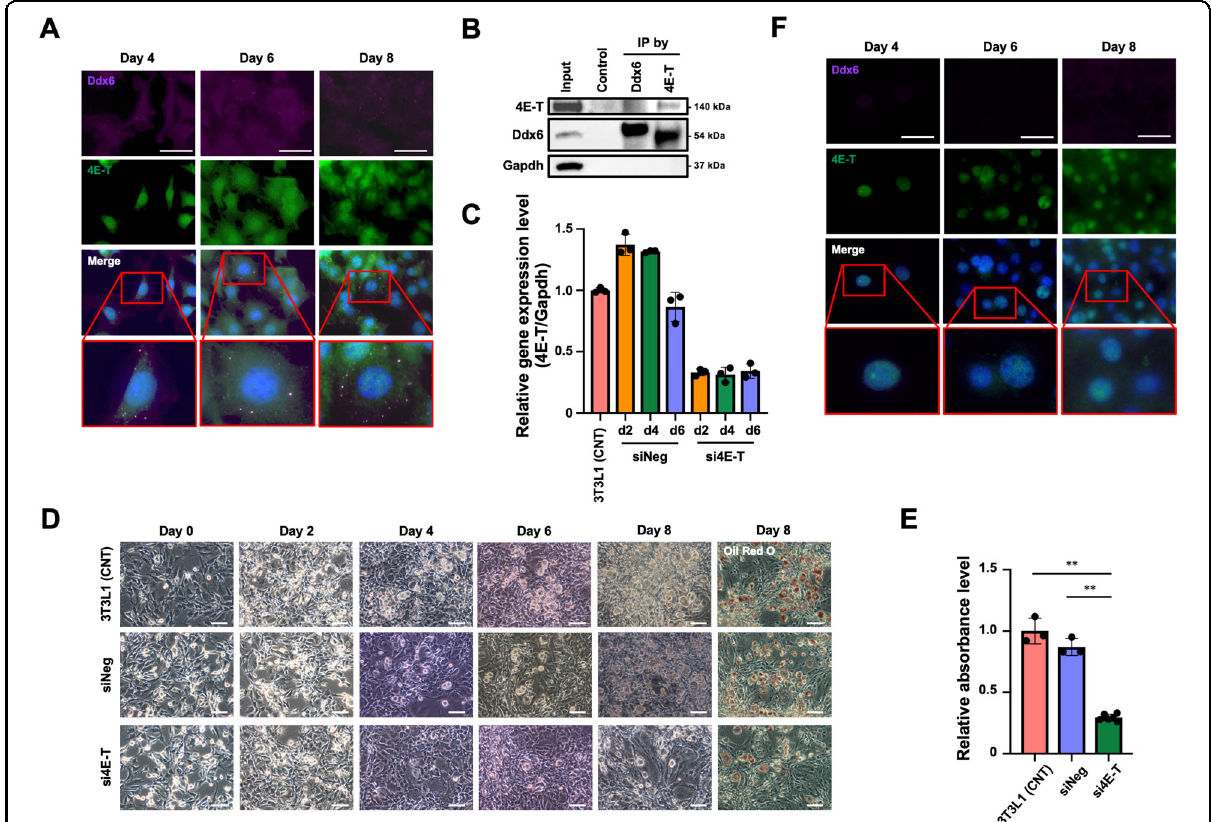
Fig. 3 Adipogenic differentiation of 3T3L1 4E-T-KD preadipocytes. A Immunocytochemistry of 3T3L1 preadipocytes during adipogenesis. Foci of Ddx6 and 4E-T proteins were merged. The scale bar is 50 μ m. Nuclei were stained with DAPI. B Immunoprecipitates bound by Ddx6 or 4E-T antibodies were analyzed by western blotting with anti-Ddx6 and anti-4E-T antibodies. C RT-qPCR analysis of 4E-T expression on each day. Individual RNA expression levels were normalized to Gapdh expression levels. The error bars indicate the SDs ( n = 3). D Phase-contrast microscopy images during adipogenesis. On day 8, the cells were fi xed and stained with oil red O. The scale bar is 100 μ m. E Relative absorbance of oil red O. The error bars indicate the SDs ( n = 3). Double asterisks (**) indicate signi fi c ance ( P < 0.01). F Immunocytochemistry of 3T3L1 4E-T-KD preadipocytes during adipogenesis. The scale bar is 50 μ m. The nuclei were stained with